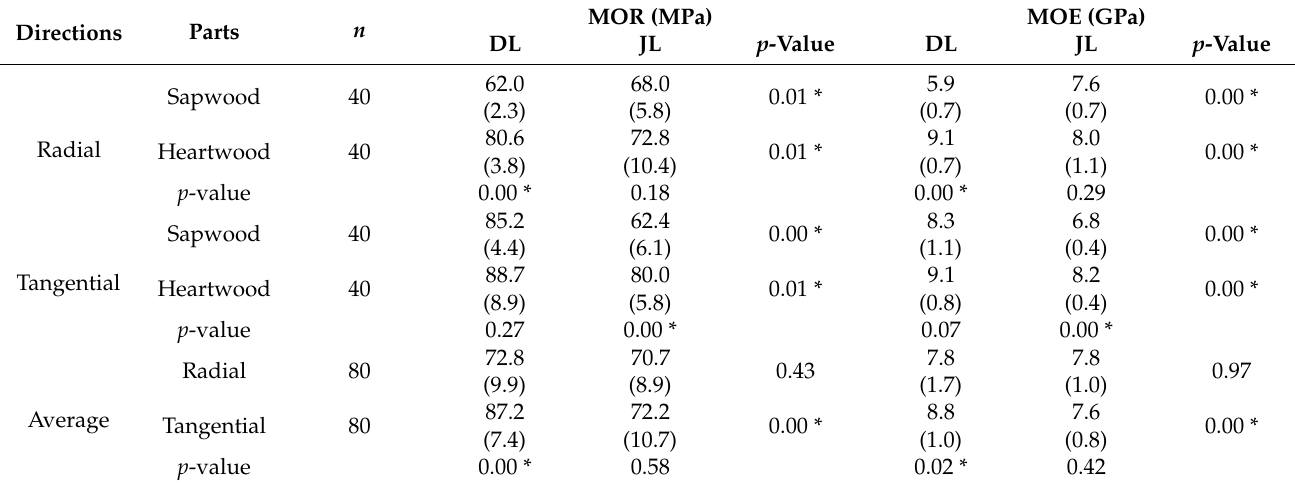
Table 4. Bending properties of Dahurian larch and Japanese